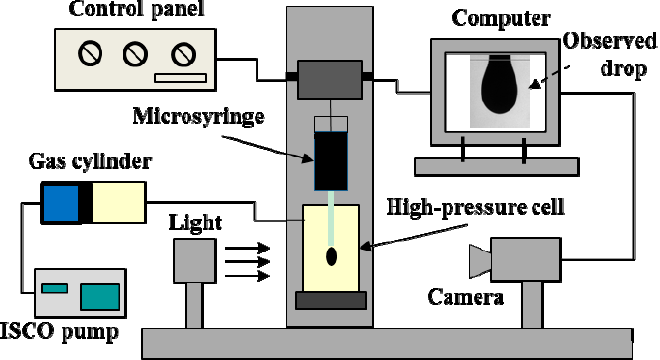
Figure 2. Schematic of the pendant drop tensiometer.